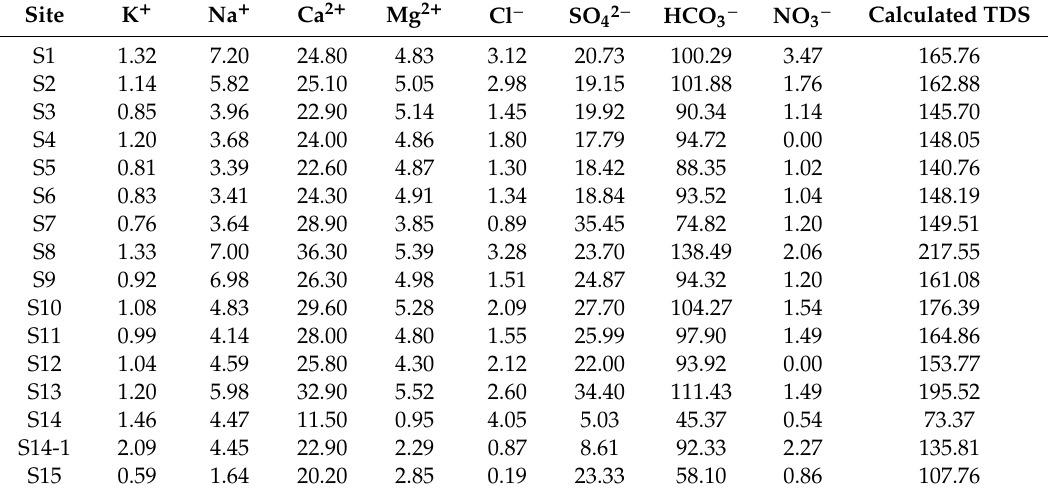
Table 3. The contents of main ionic components of the Lhasa River (mg /